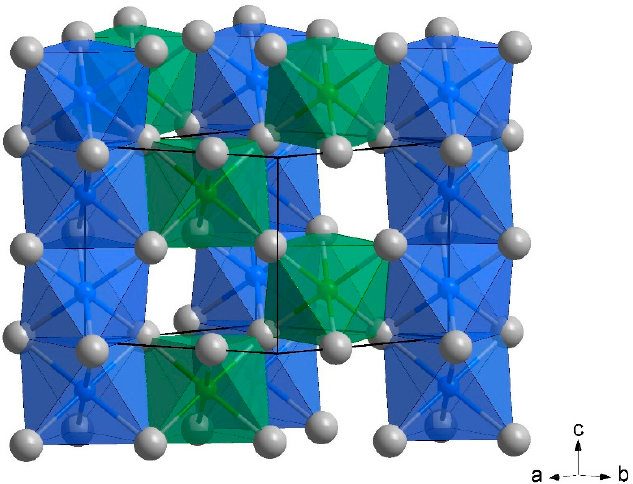
Figure 1. Crystal structure of ε -Fe 2 MnN. Grey spheres represent Fe / Mn, green and blue spheres represent nitrogen. Exclusive occupation of the green octahedra (site 2 c ) results in the ideal ordered crystal structure of ε -Fe 3 N. Entropy-driven nitrogen transfer from site 2 c to partially occupied 2 b (blue octahedral) is typically observed.